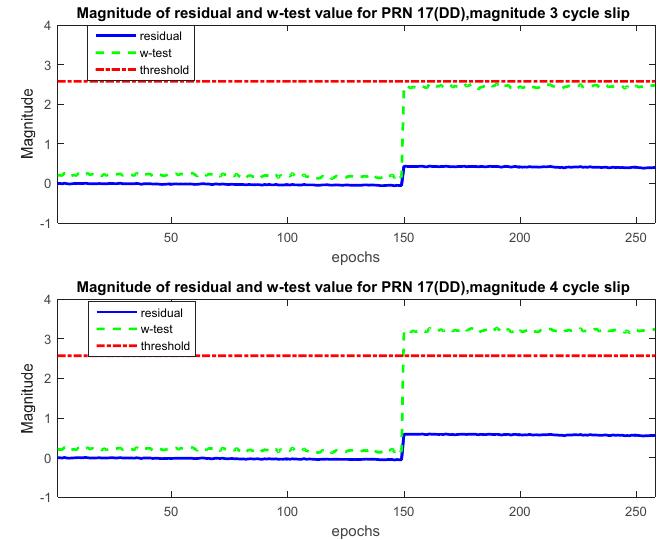
Figure 8. w -Test values for PRN 17 (dataset 1), α 0 = 1%.